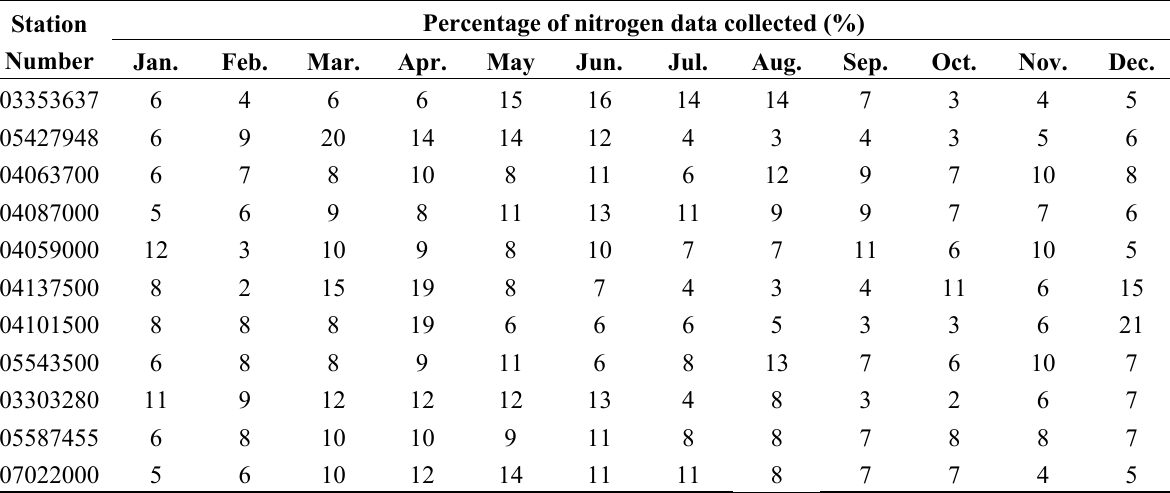
Table 3 . Percentage of nitrogen data collected in each